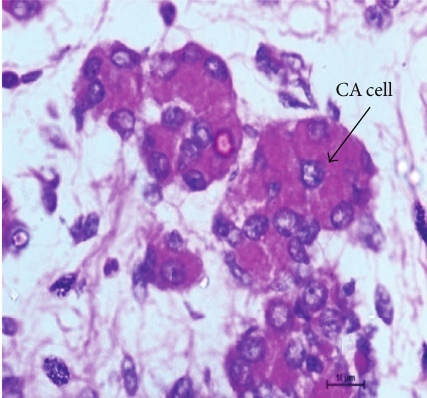
Figure 5: 12.8 cm CVRL (86 days) showing centroacinar (CA) cell. Hematoxylin and eosin × 1000.